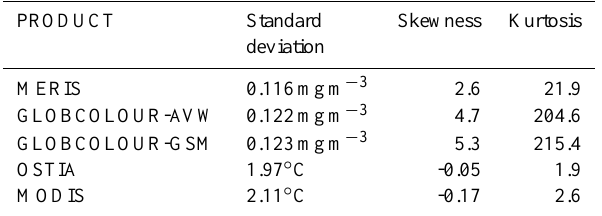
Table 2. Values of the standard deviation, skewness and kurtosis of the singularity exponents for the different